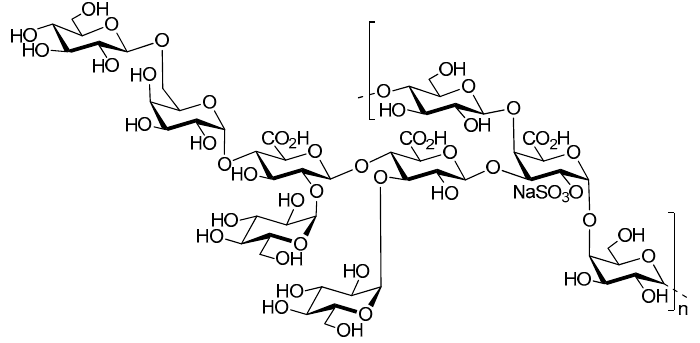
Figure 1. Structure of the GY785 exopolysaccharide (EPS) repeating unit [27].